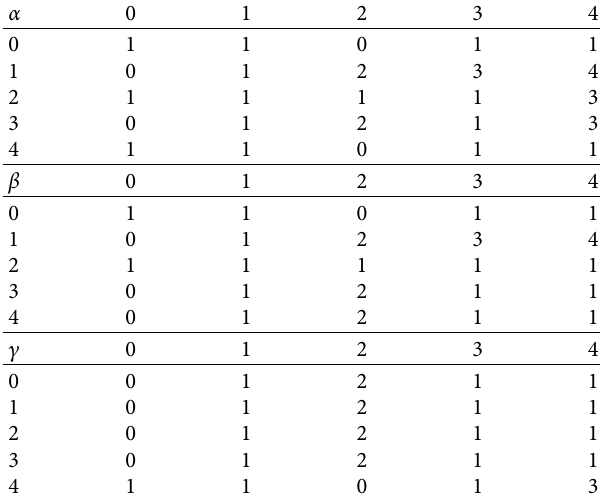
Table 9: Cayley tables for the binary operations “ α , β , and c